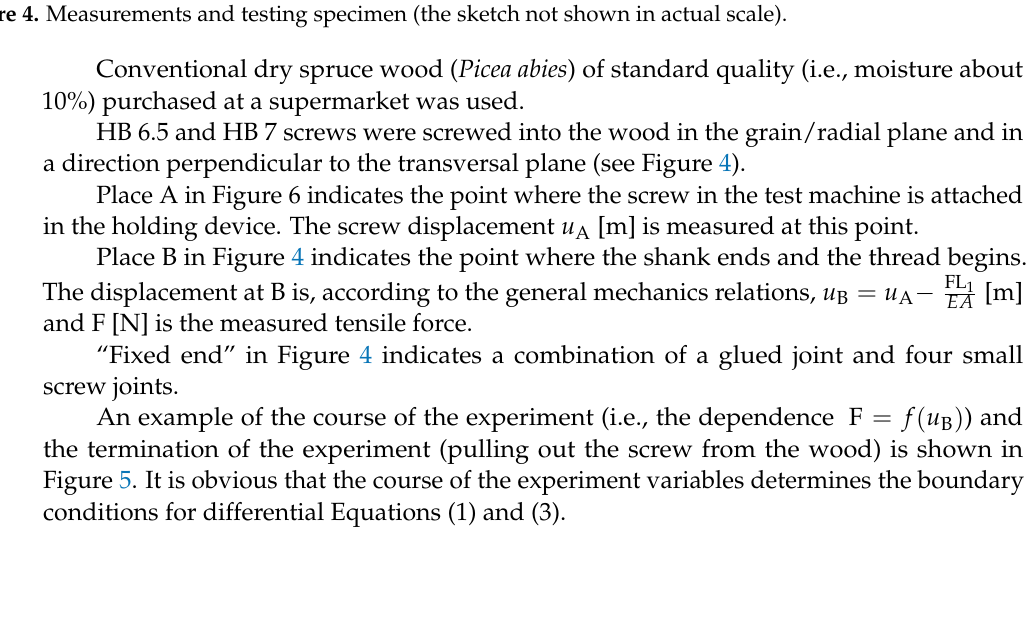
Figure 4. Measurements and testing specimen (the sketch not shown in actual scale).